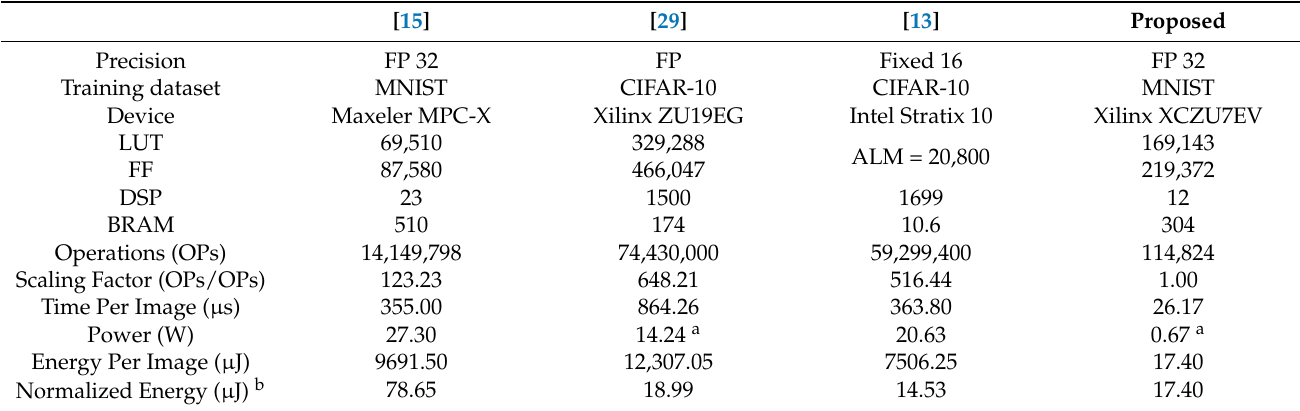
Table 6. Comparison of resource usage, execution time, average execution power, and normalized energy consumption with the existing works.